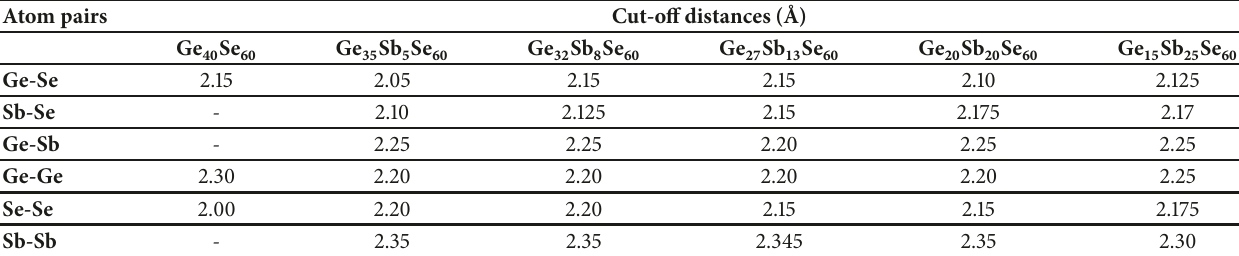
Table 2: Cut-off distances (˚A) for atom pairs used in the final RMC